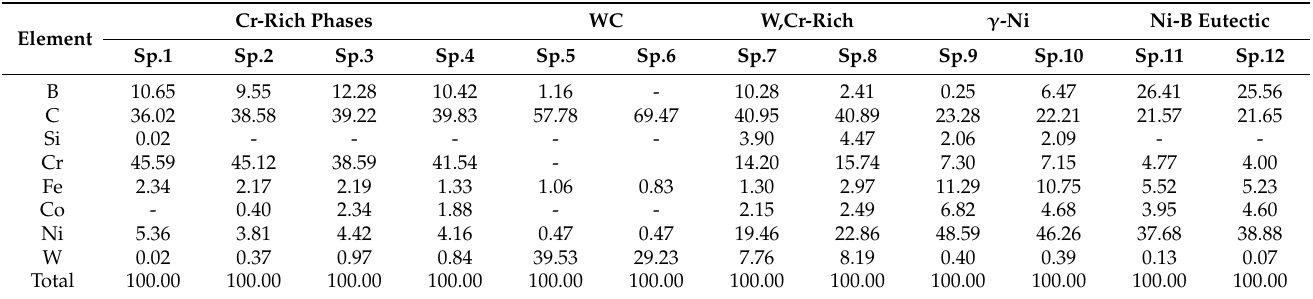
Figure 2. SEM micrographs of the coating remelted in a furnace ( a , b , d , e ) and the graph of elemental distribution across the interface between the coating and the substrate ( c ): ( a ) general view of the remelted coating; ( b ) enlarged view of interface zone with marked points of EDS analysis; ( d ) microstructure of the coating representing the presence of different types of hard precipitates with marked points of EDS analysis; ( e ) enlarged view of metal matrix microstructure with marked points of EDS analysis. Table 2. Elemental composition of phases in furnace remelted coating (EDS;